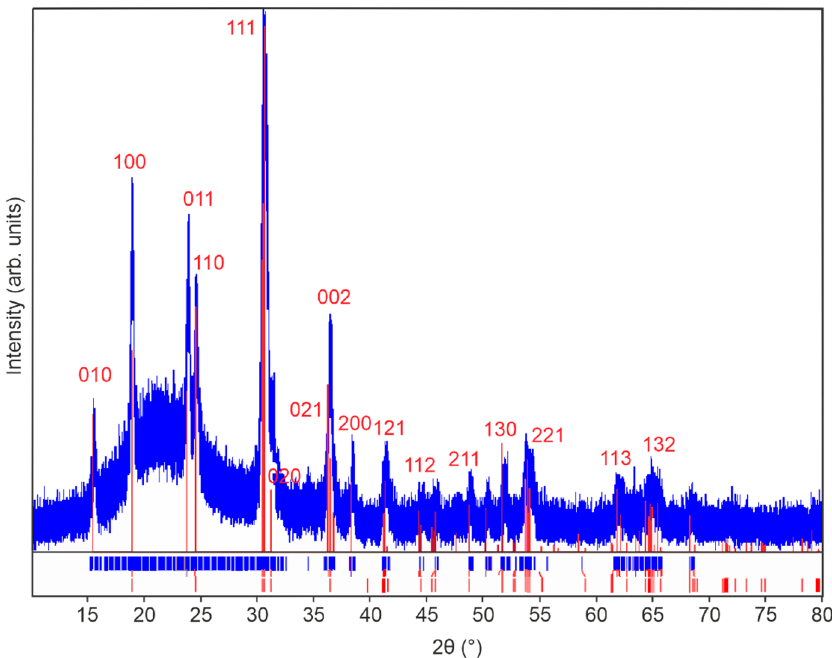
Figure 2. X-ray diffractogram of 100 nm monoclinic ZnWO 4 thin films annealed in air at 600 °C for 10 h. PDF card 96-591-0159 is used as reference and is shown in red.